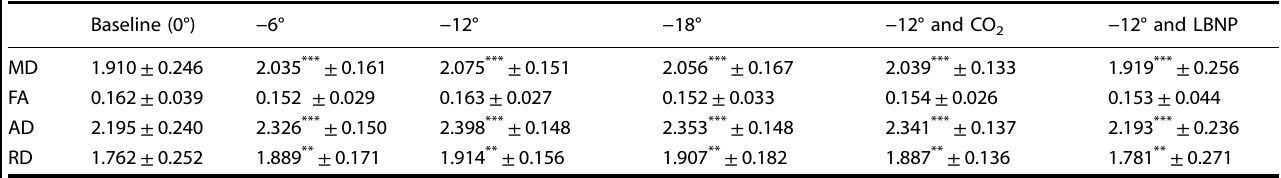
Table 1. Mean diffusivity (MD), fractional anisotropy (FA), axial diffusivity (AD), and radial diffusivity (RD) of CSF (cerebrospinal fl uid) in the optic nerve (ON) sheath Baseline (0°)